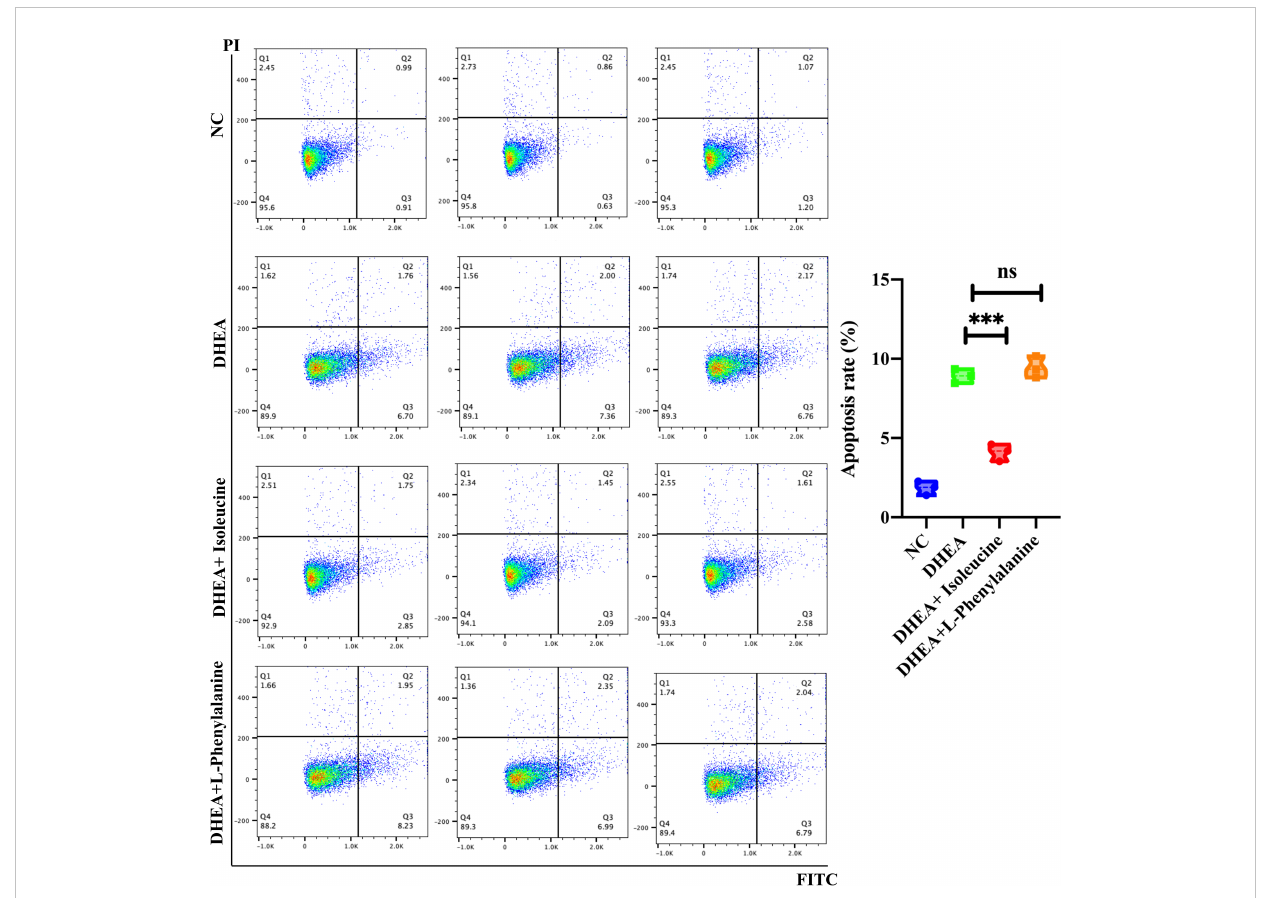
FIGURE 5 Analysis of the cell apoptosis of KGN cells transfected with DHEA (10 − 4 M) and isoleucine (20 m M) or L-phenylalanine (20 m M). The early and late apoptosis rates of KGN cells were compared using PI and FITC. ***p < 0.001; ns, non-signi fi